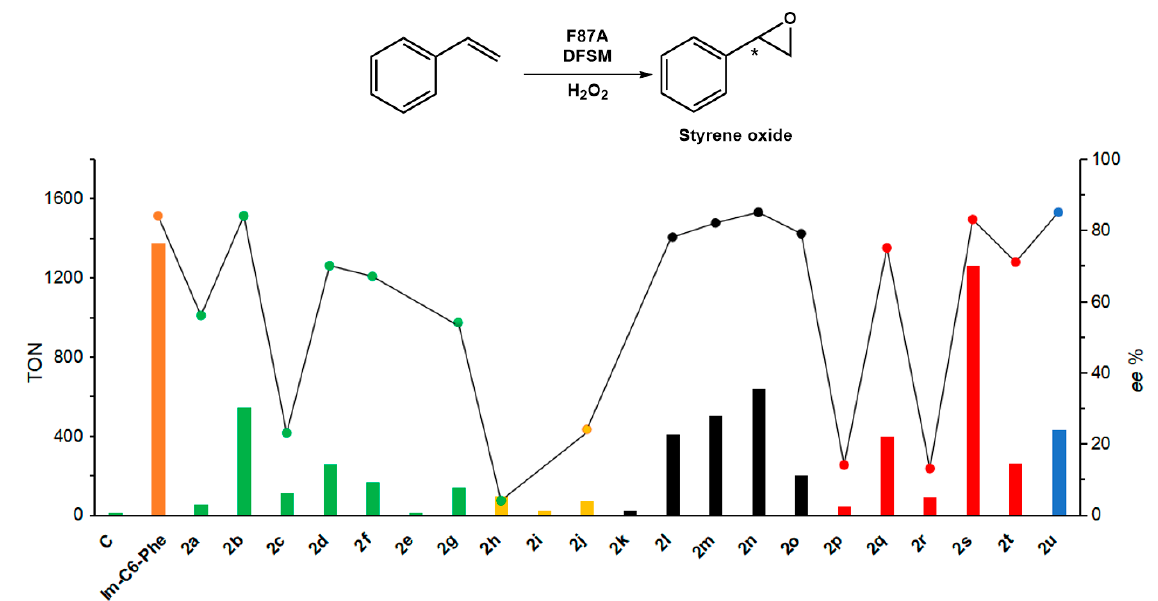
Figure 2. H 2 O 2 -dependent epoxidation of styrene catalyzed by P450BM3 in the absence/presence of DFSMs. ee , enantiomeric excess (%) of ( R )-styrene oxide determined by chiral GC and was calculated by (( R )-styrene oxide − ( S )-styrene oxide)/(( R )-styrene oxide + ( S )-styrene oxide) according to the corresponding peak area. TON: Turnover numbers were estimated for 30-min reactions. In this study, TON is also the maximum number of substrate molecules that were catalyzed by one enzyme molecule, since the system is inactivated by the high concentration of H 2 O 2 within 30 min. The TON and ee % values are presented as bar charts and stacked line charts, respectively. *: The chiral carbon atom.